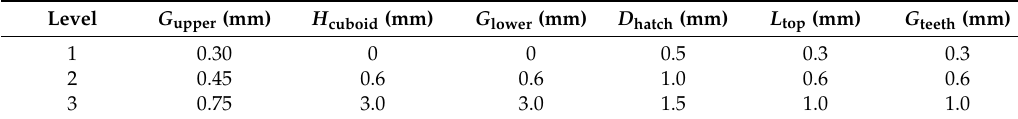
Table 3. Support parameter values.